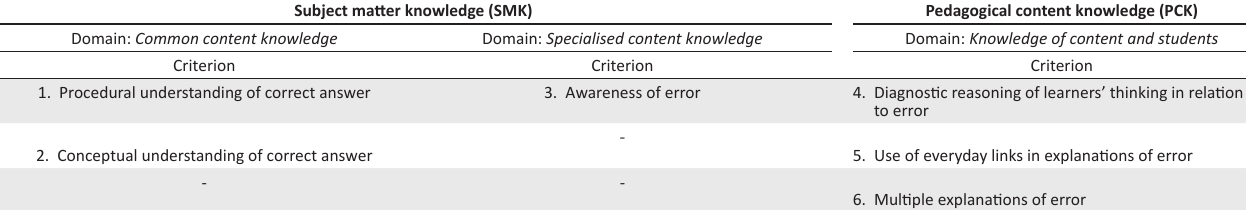
TABLE 1: Domains of teacher knowledge and related error analysis